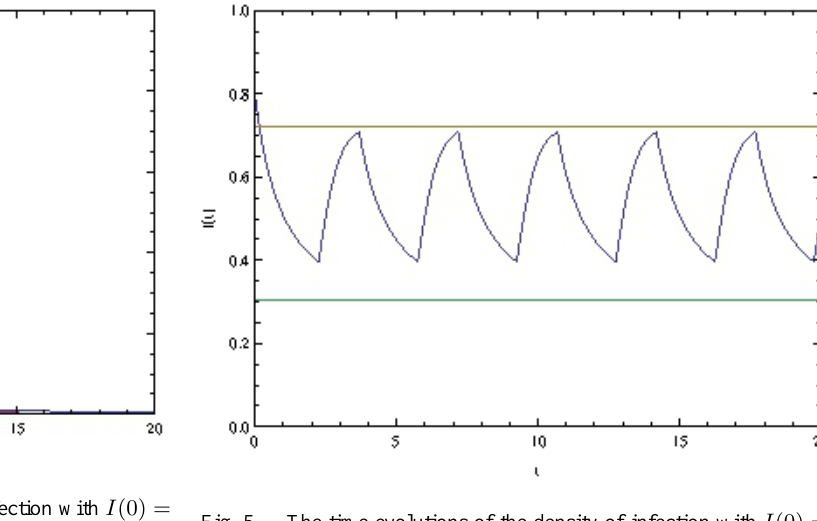
The time evolutions of the density of infection with I (0) =